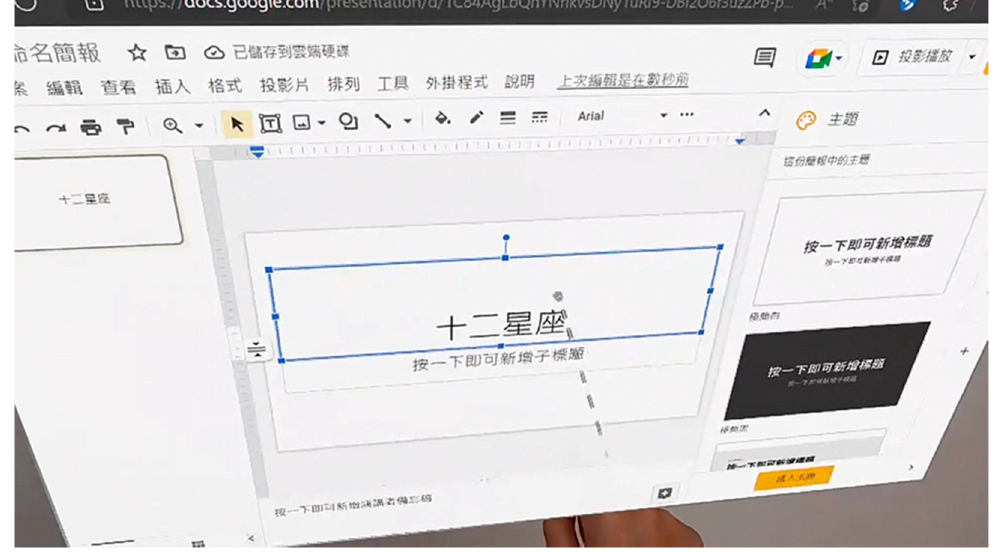
Figure 6. Screenshot of the 3D Google Slides captured through HoloLens 2.